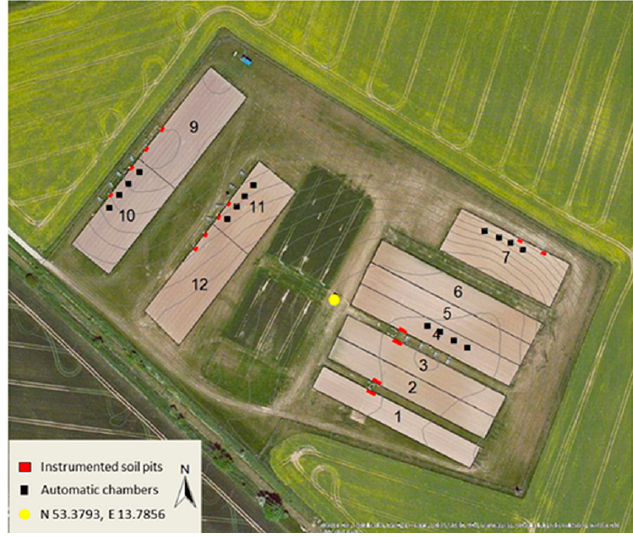
Figure 1. The CarboZALF experimental area near Dedelow (NE Germany): plot design and